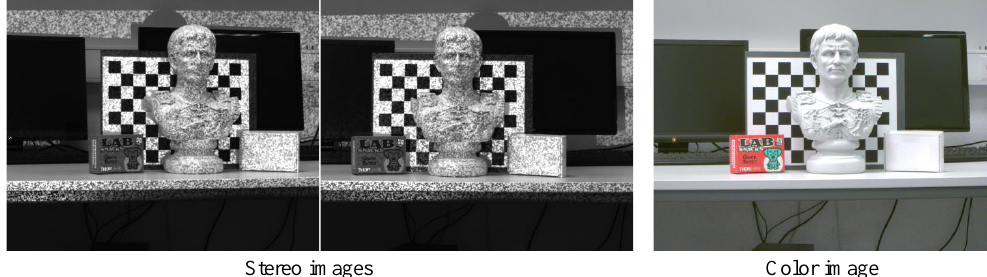
Figure 3. Synchronized triple images from one-shot acquisition. From left to right are respectively stereo gray image pair with active blue random patterns and the color image after long pass filtering.